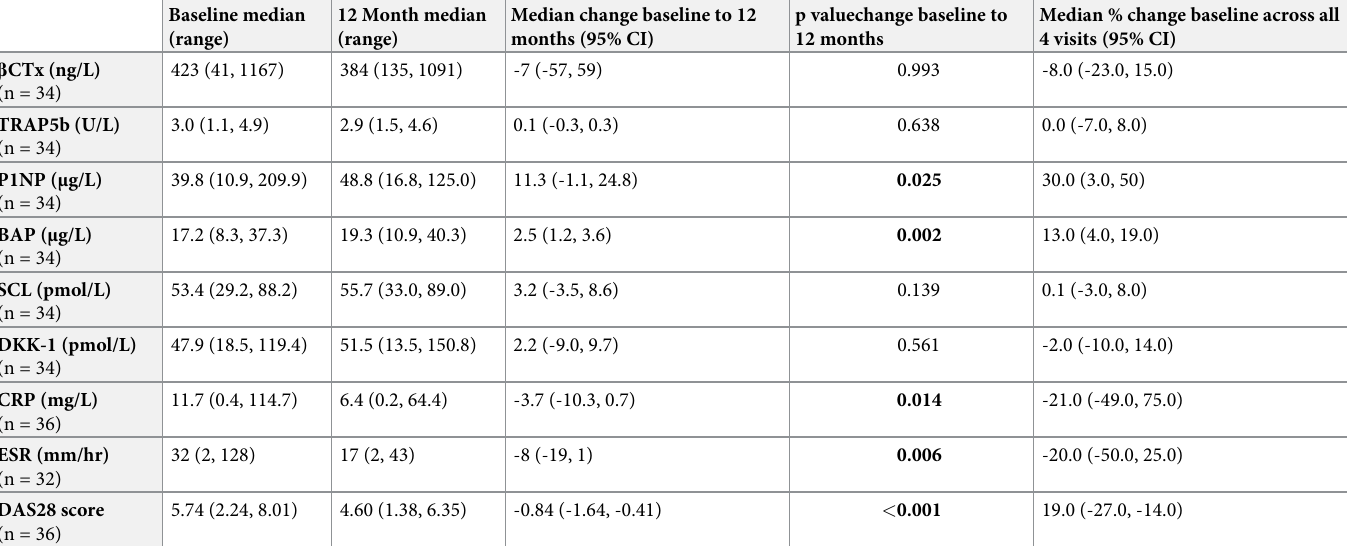
Table 3. Change in median biomarkers from baseline to 12 months.